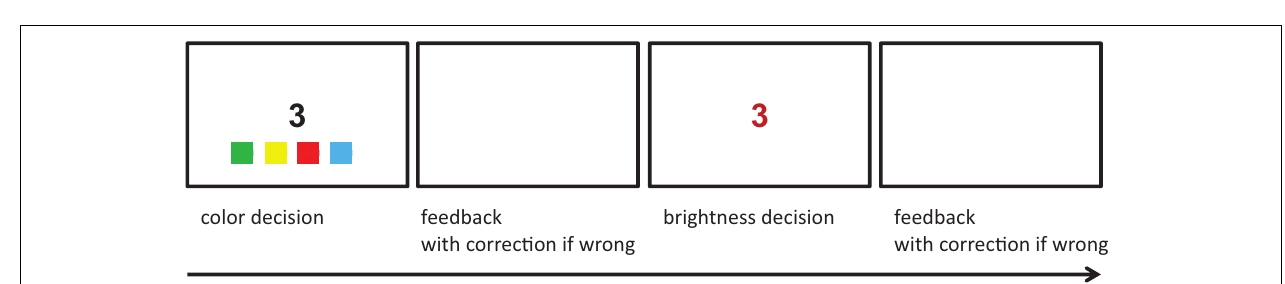
with correc(cid:3)on if wrong